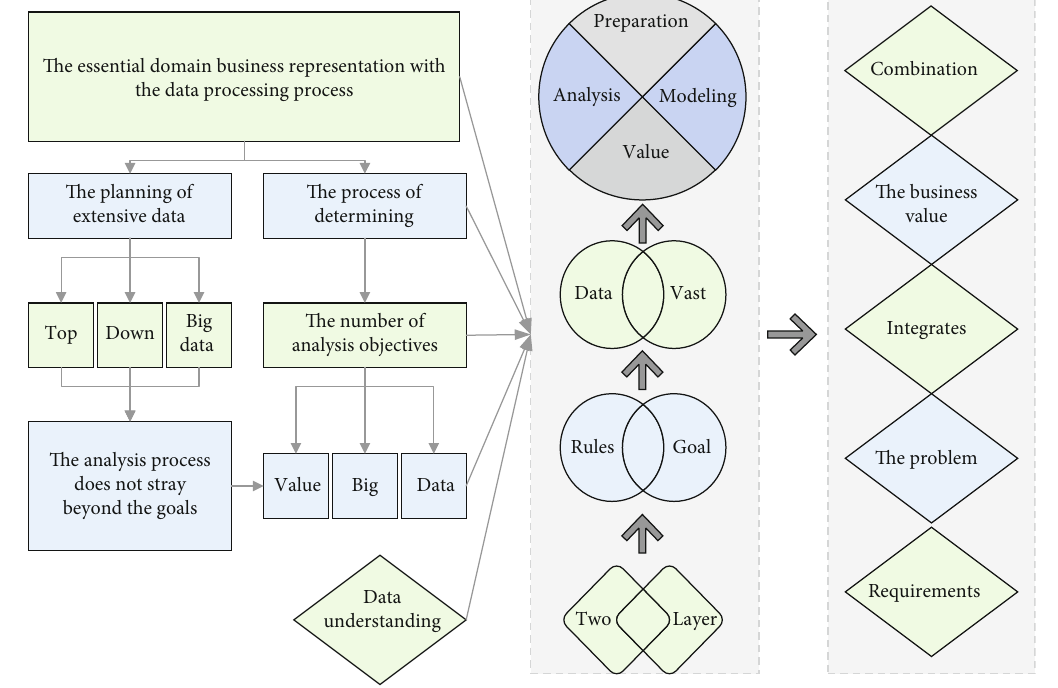
Figure 2: Big data analysis process processing